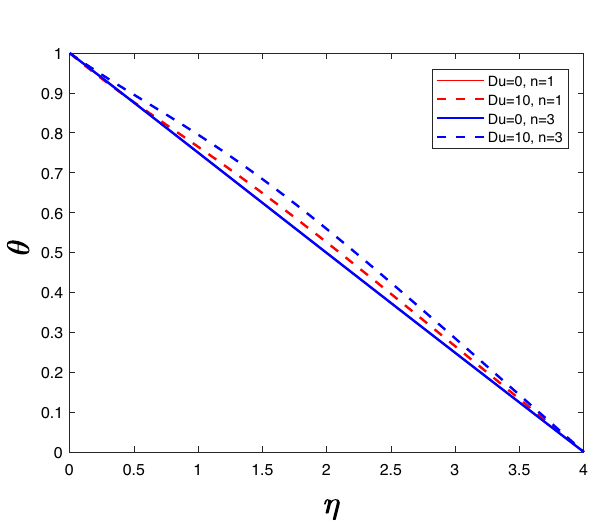
Figure 7. Temperature profile for various Du